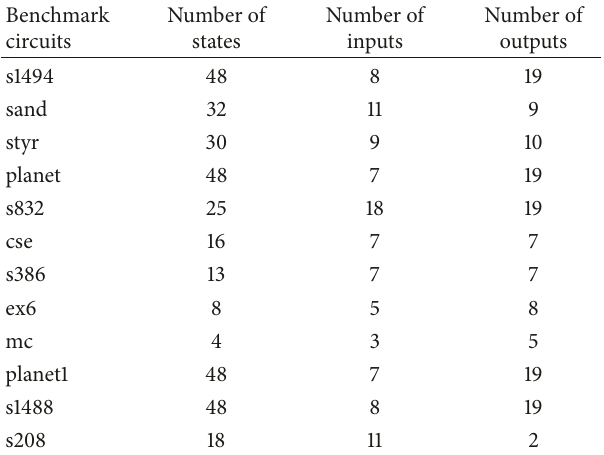
Table 1: Benchmark circuits from MCNC/LGSynth